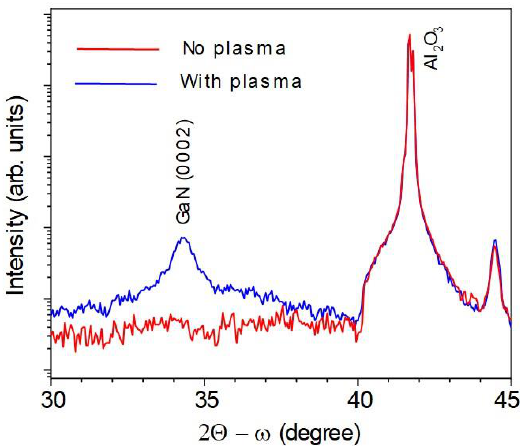
Figure 5. XRD spectra measured for the GaN layers grown at 620 °C directly on sapphire (0001) substrates with plasma (blue line) and without plasma (red line) generation of nitrogen precursor. The peak at ~44.3 degrees is related to the holder.